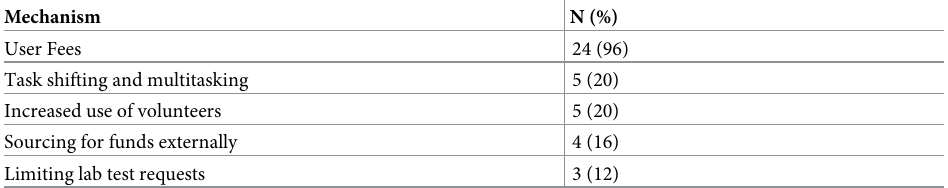
Table 3. Coping mechanisms adopted by APIN supported facilities in response to policy